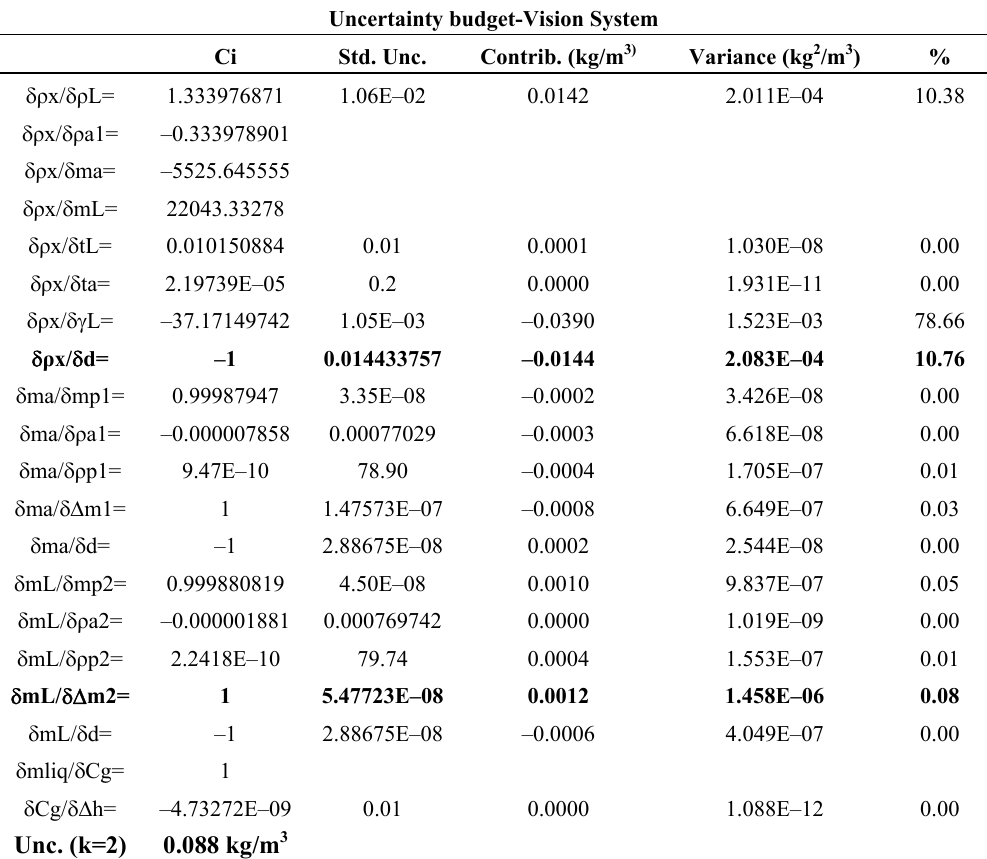
Table 13. Uncertainty budget – Vision System method – d = 0.5 kg/m 3